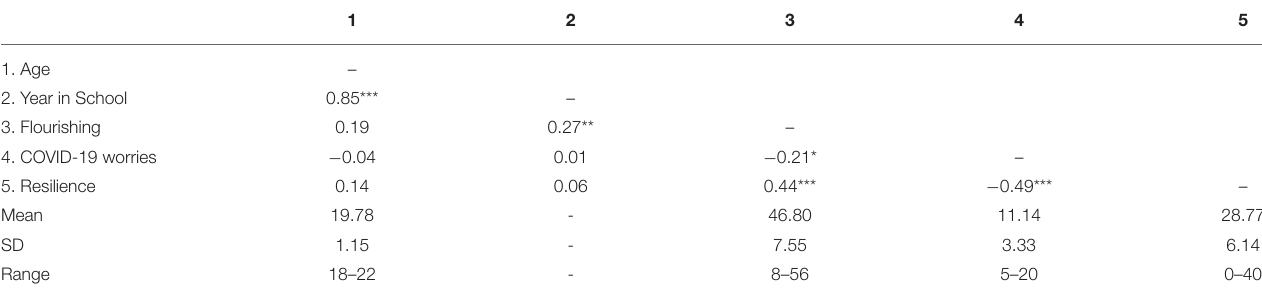
TABLE 1 | Descriptive statistics and bivariate correlation estimates ( N =